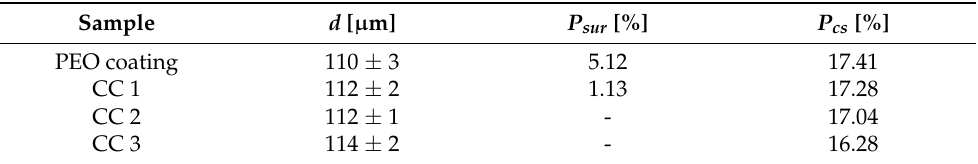
Figure 2. SEM images of cross-section of PEO coating and CC 3 on aluminum alloy. Table 1. Thickness and porosity of PEO and composite coatings formed on aluminum alloy ( d is a coating thickness, and P sur and P cs are surface porosity and porosity within the coatings’ cross-section, respectively).